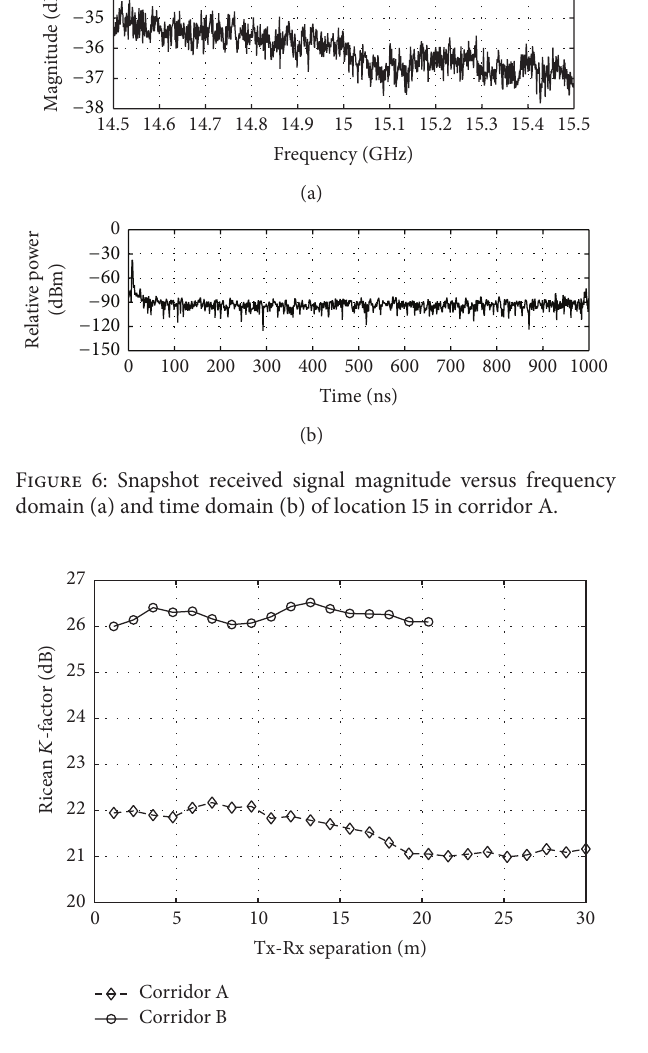
Figure 7: Ricean 𝐾 -factor versus link distance.